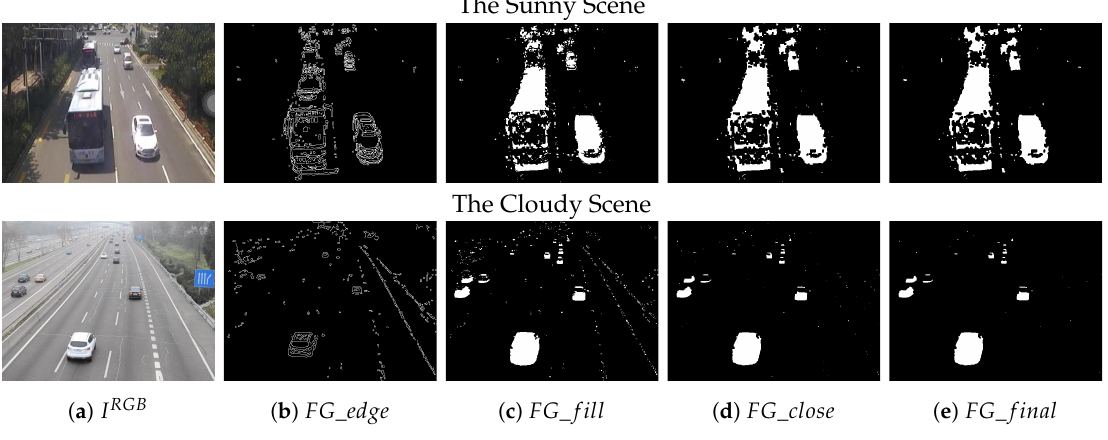
Figure 7. The extraction of the optimized